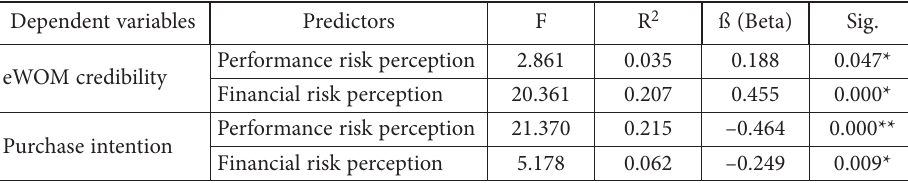
Table 5. Regression analysis results for prevention-focused